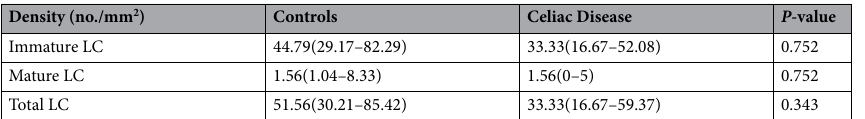
Table 2. Langerhans cells in children with Celiac Disease and controls. *Data is presented as mean ± SD, CeD: celiac disease, LC: Langerhans cells.